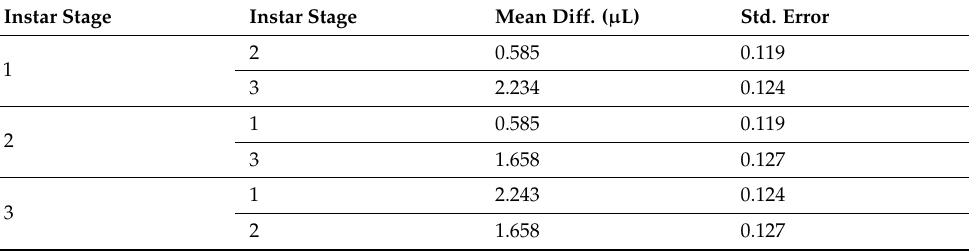
Table A3. Pairwise comparison (equal variances not assumed) to identify if honeydew volume produced by individual Marchalina hellenica differed between instar stages. All pairs differences are statistically significant ( p <